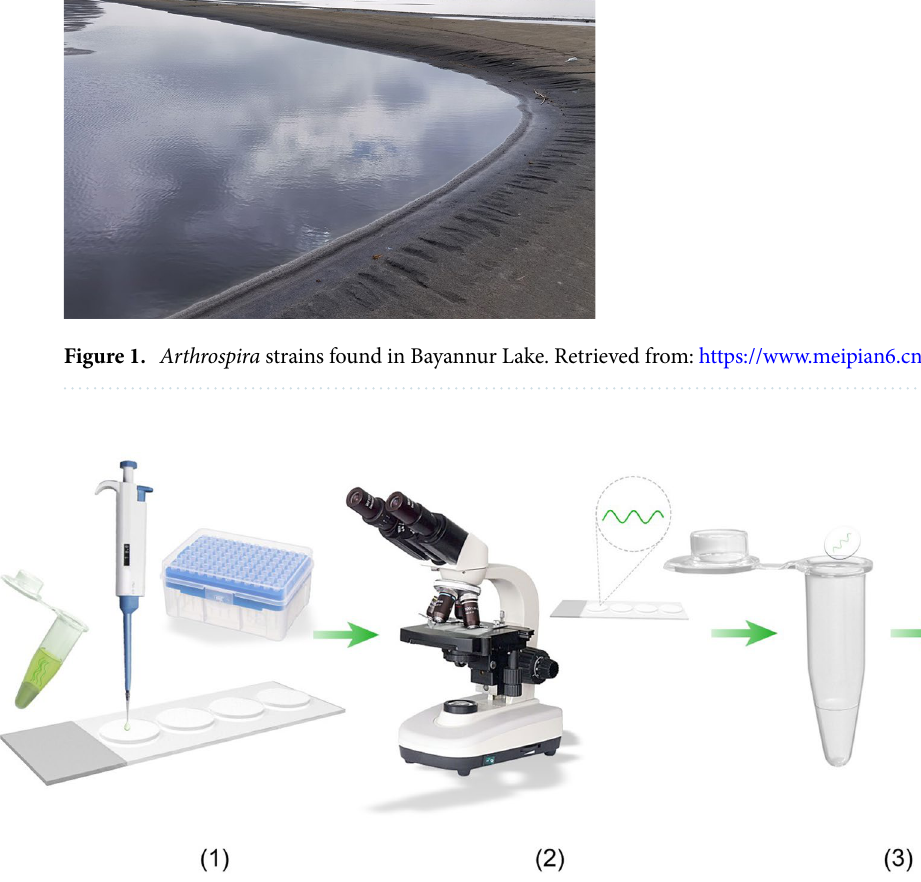
Figure 2. The progress of separating and purifying the five Arthrospira strains. Made by 3dmax (2020) and Photoshop cc